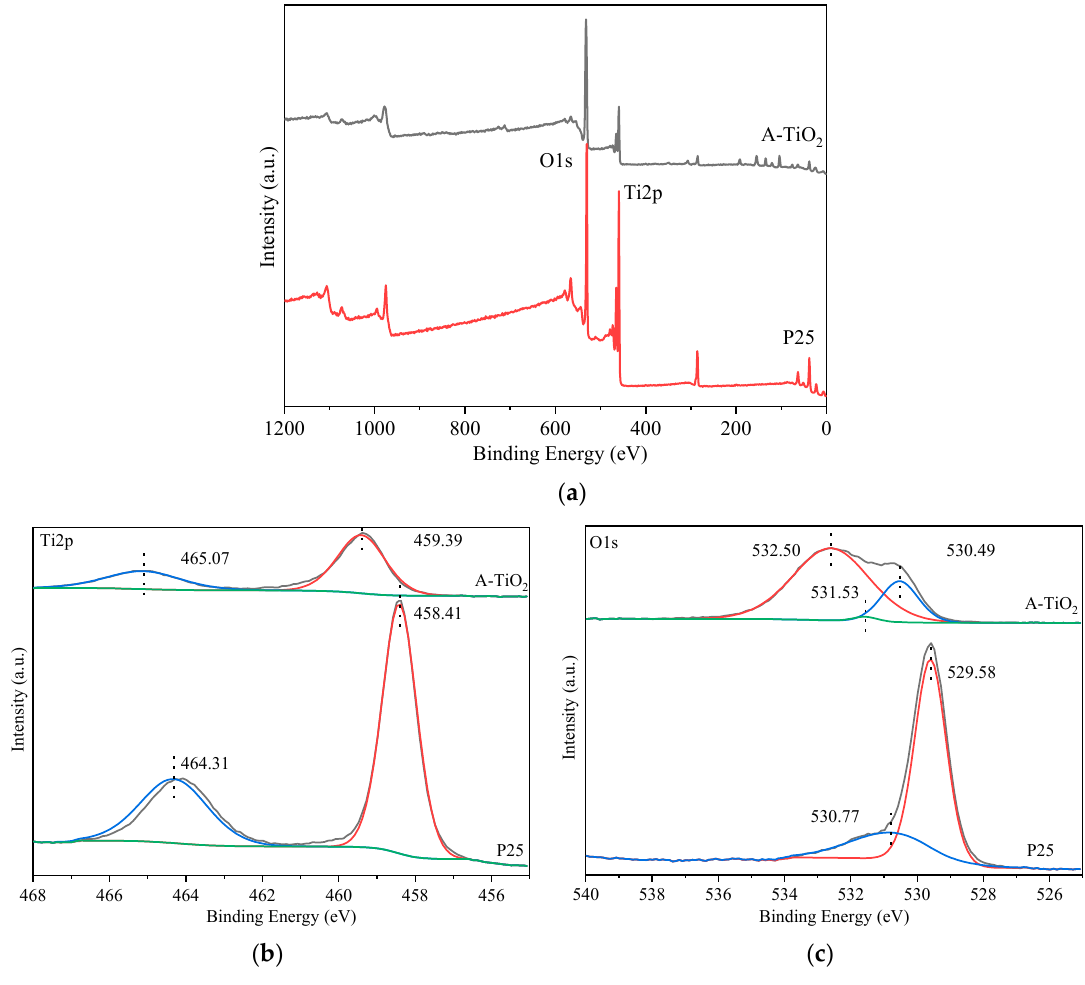
Figure 4. ( a ) X-ray photoelectron spectroscopy (XPS) survey spectra, ( b ) Ti 2p spectra, and ( c ) O1s spectra of A-TiO 2 and P25.